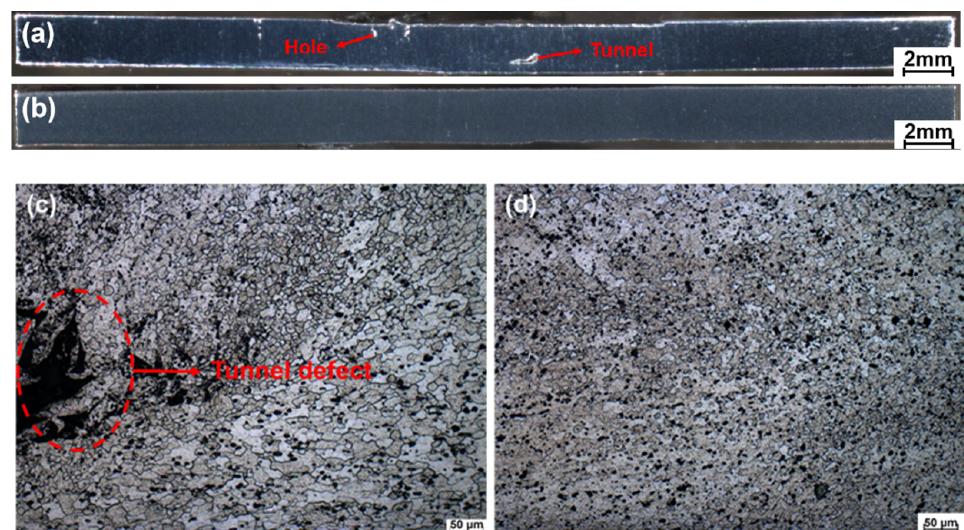
Figure 5. Macro forming of weld section and NZ under different spindle speeds, ( a ) Macro section at 6000 rpm, ( b ) Macro section at 12,000 rpm, ( c ) Micro section of the NZ at 6000 rpm, ( d ) Micro section of the NZ at 12,000 rpm.